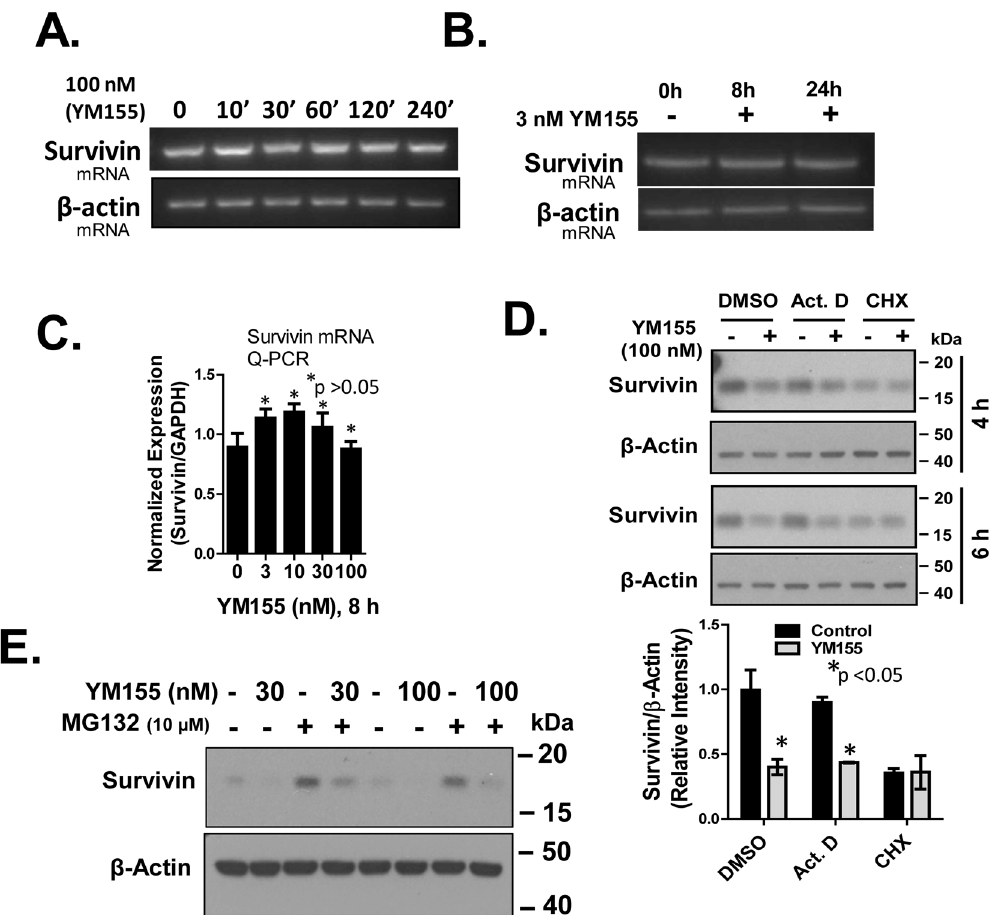
Figure 3. Suppression of endogenous Survivin by YM155 occurs through a non-transcriptional mechanism. ( A ) Effect of 100 nM and 3 nM YM155 the endogenous Survivin mRNA in PC-3 was assessed by semi- quantitative RT-PCR at the indicated times and quantitative real-time PCR at 8 h treatment ( C ). ( D ) Effect of 100 nM YM155 (4 and 6 h) on the expression Survivin in PC-3 pretreated for 30 min with Act D (2 μ g/ml) or CHX (2 μ g/ml), assayed by Western blot and quantified by Image J analysis. ( E ) Effect of MG132 (10 µ M) on the suppression of Survivin by 30 nM and 100 nM YM155 in PC-3, assayed by Western blot. Each group of blots represents data obtained from a single gel and experiment. Results shown are representative of 2–3 independent